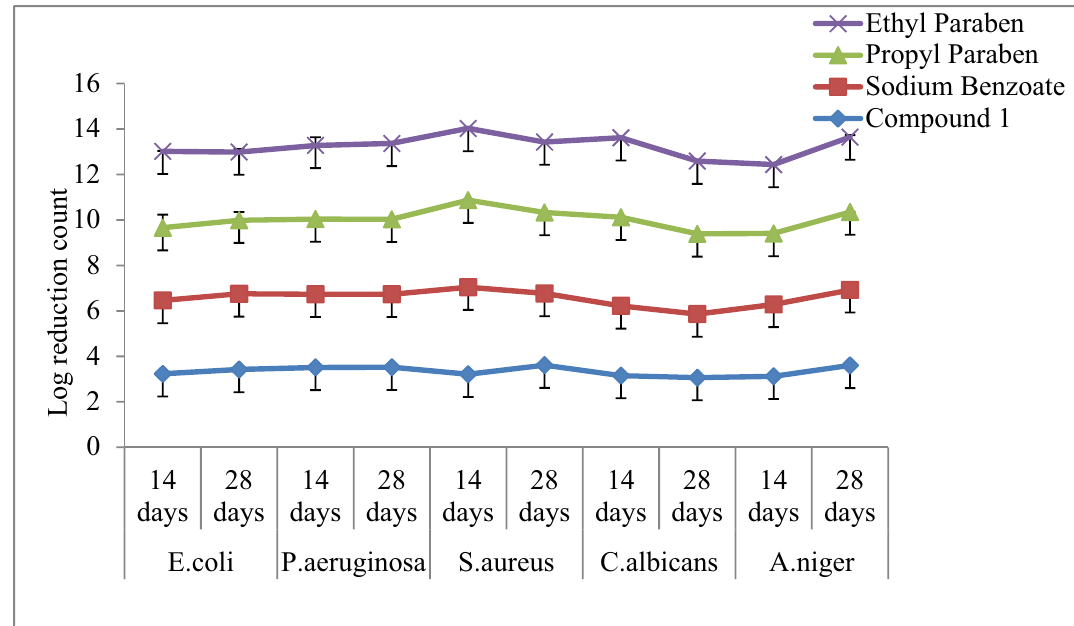
Figure 4. Preservative efficacy results of compound 1 in White Lotion USP and degree of microbial log reduction. Data are means of five replicates; standard deviation is shown as error bars. Chart indicates statistically significant differences between groups (p < 0.05).